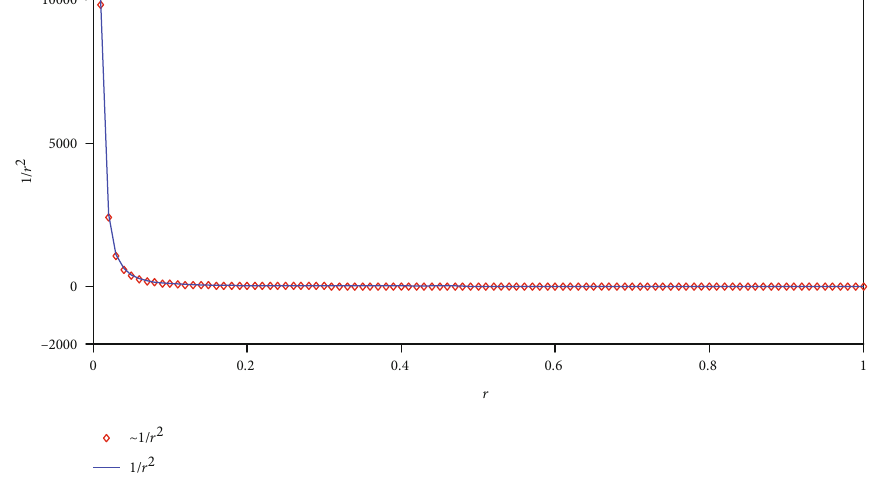
2 diatomic molecule.